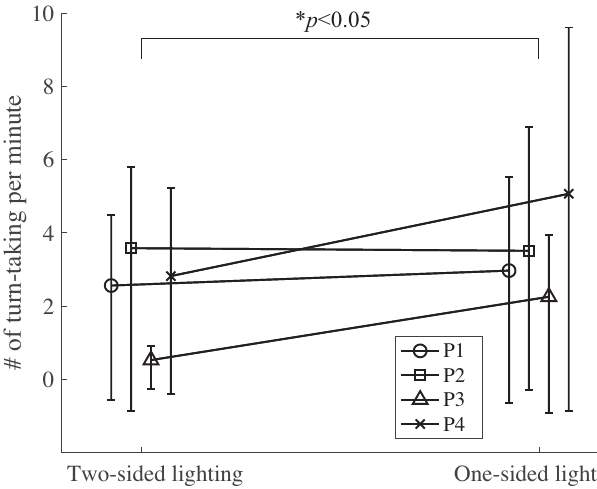
Figure 9. Average and range of turn-taking per minute counted by three coders (C1, C2 and C3). It includes the data from interventions with COLOLO with the two modified interactions rules.